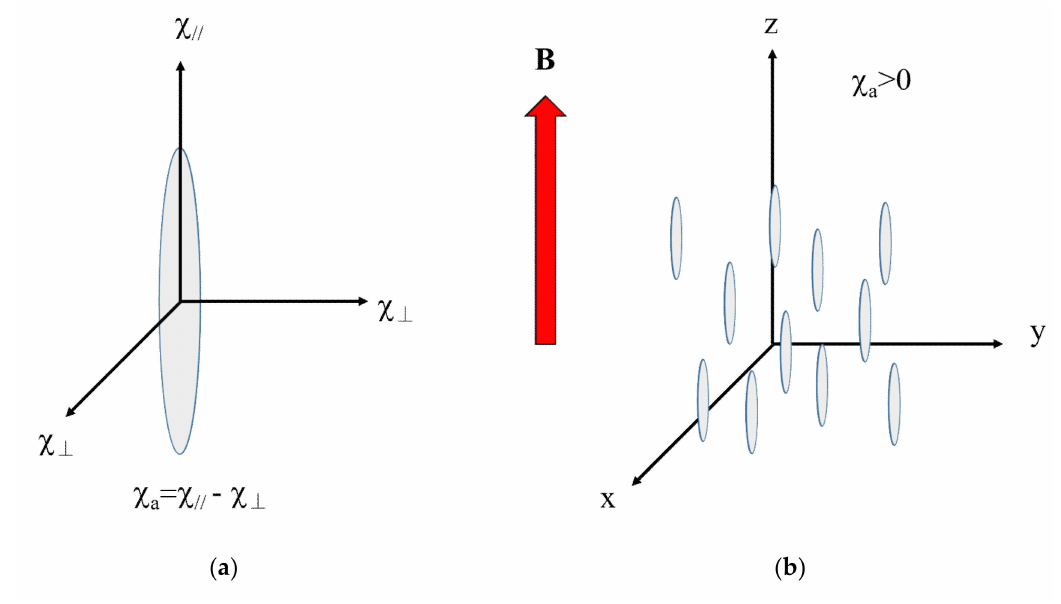
Figure 6. ( a ) Principal axes χ (cid:107) and χ ⊥ of fiber. ( b ) Schematic drawing of magnetic alignment of fibers with χ a > 0 under static magnetic